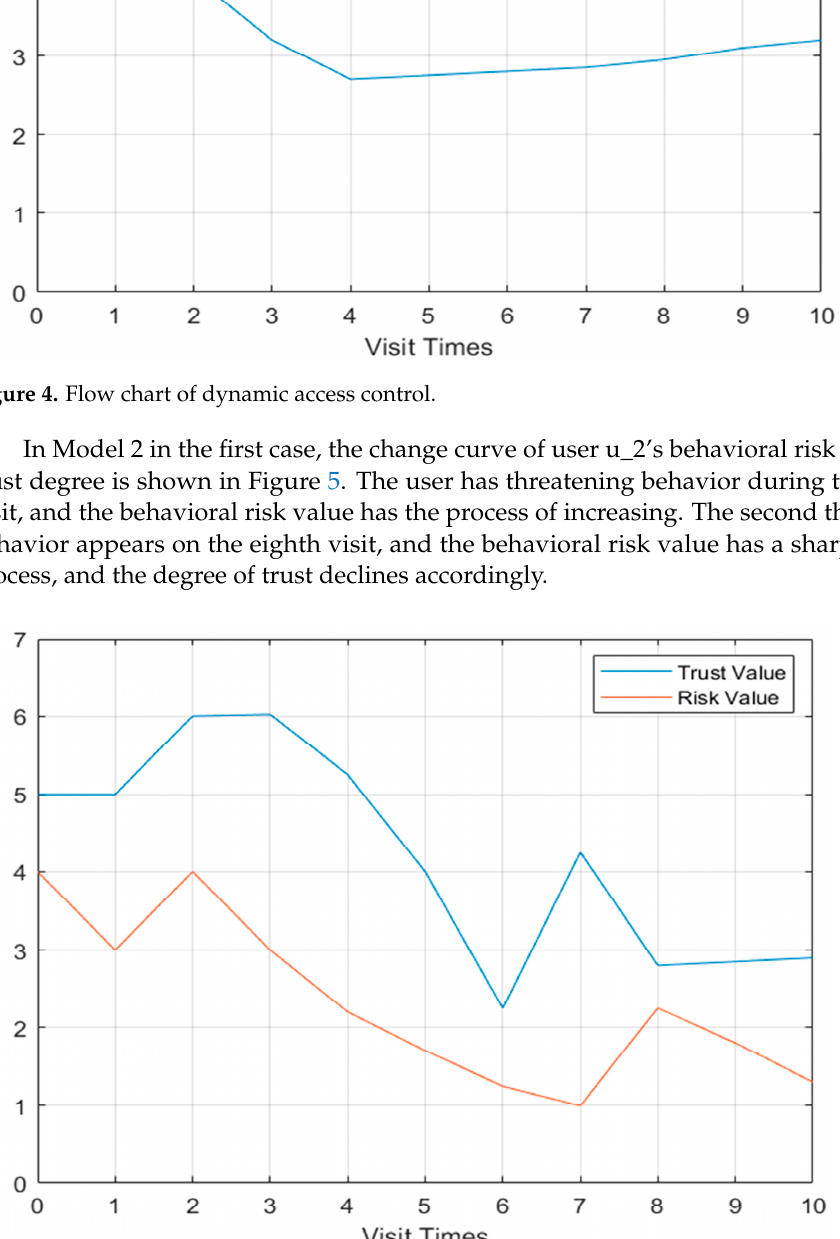
Figure 5. The u_2 behavior risk value and trust change curve Model 2.